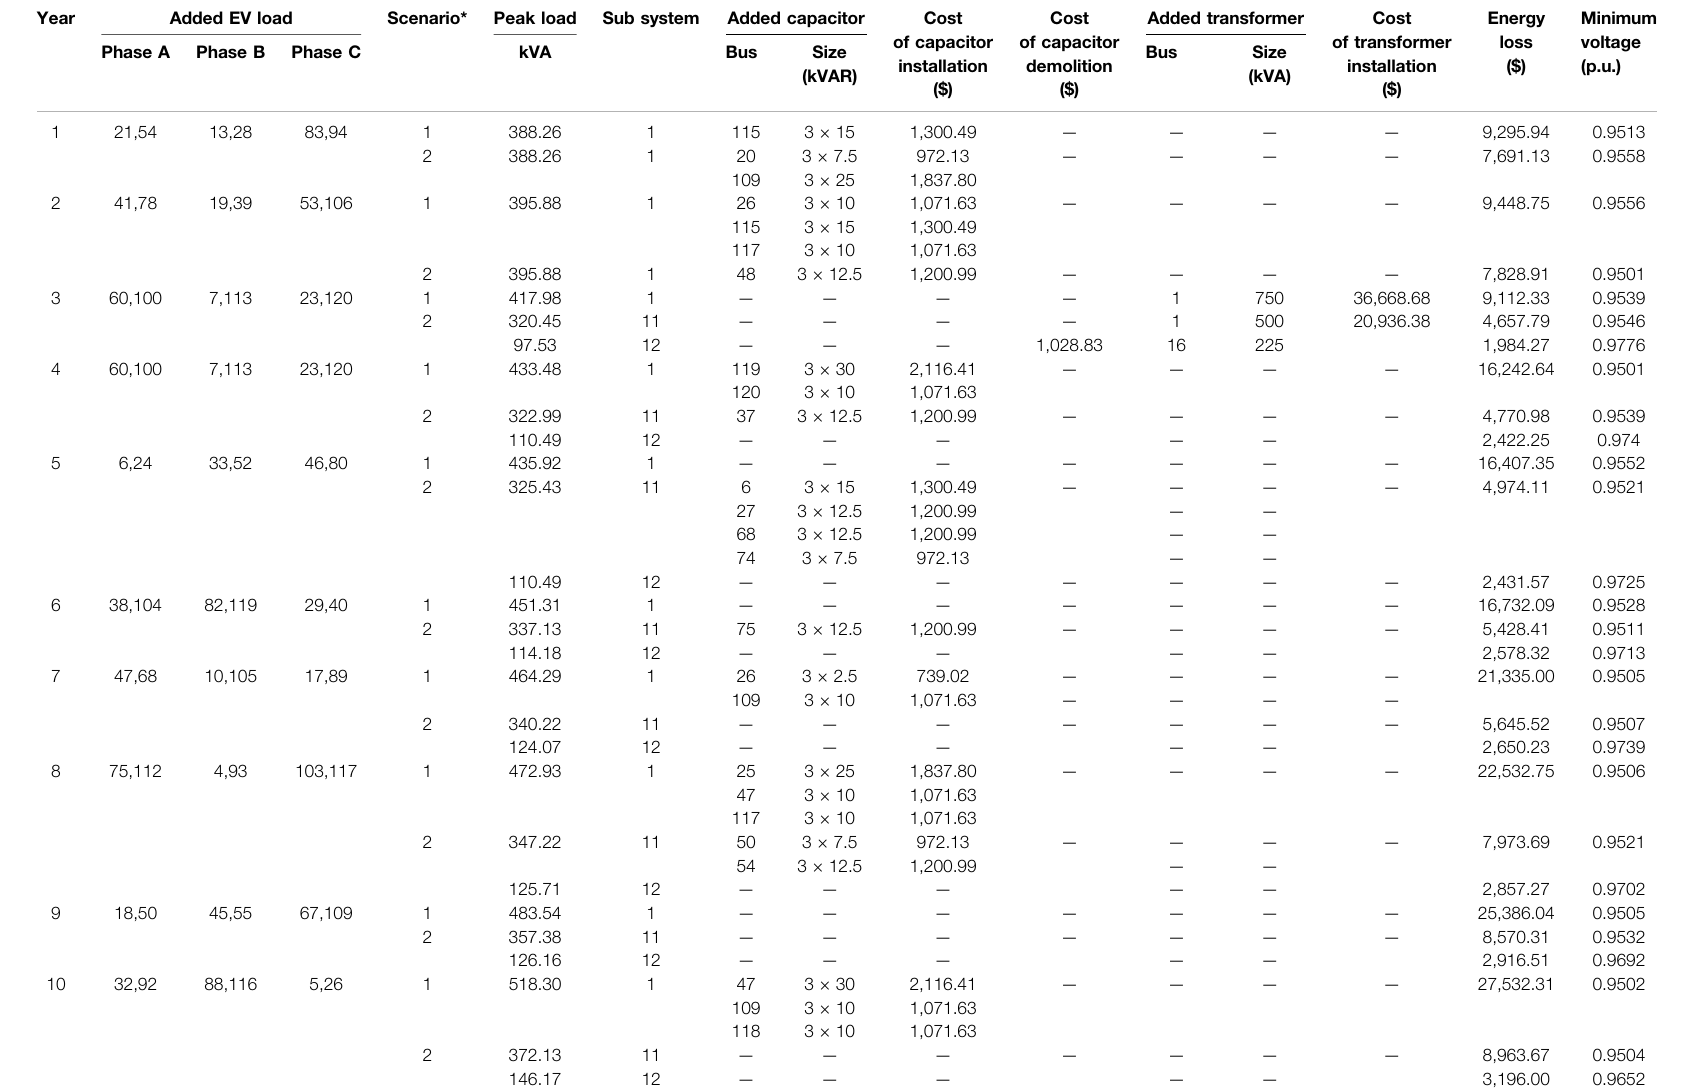
TABLE 3 | Optimal planning schedule for scenarios 1 and